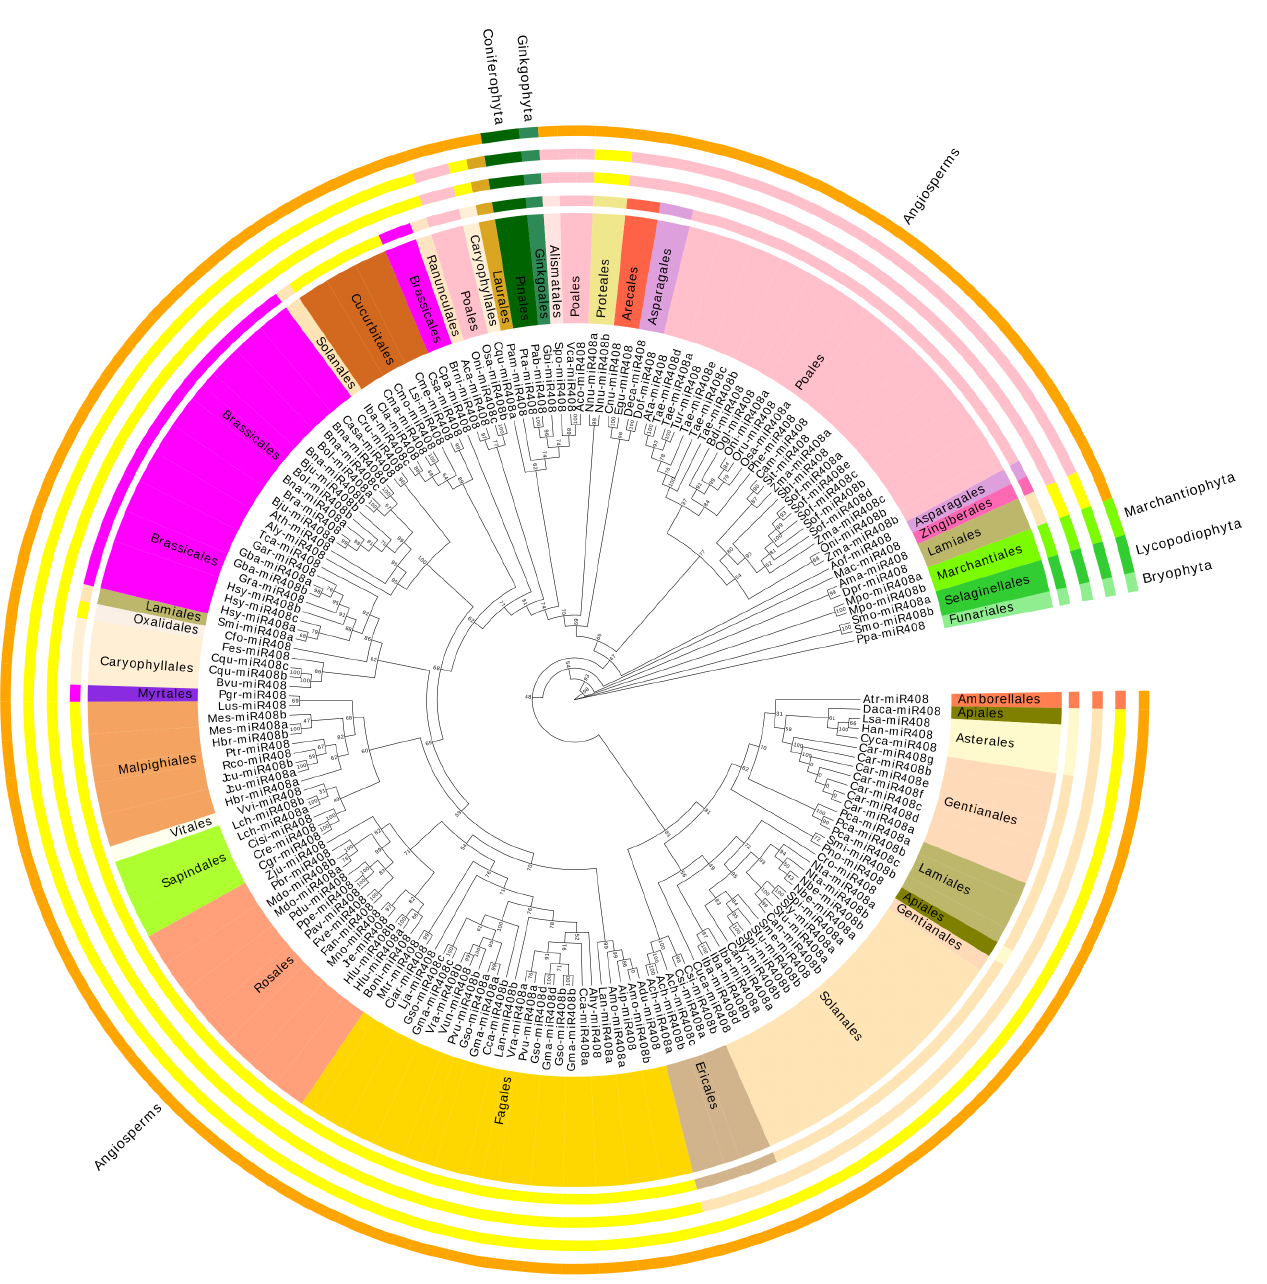
Figure 1. Phylogenetic analysis of miR408 precursor from 118 plant species. The miR408 precursor sequences were aligned with MAFFT. Maximum likelihood phylogenies were inferred using IQ-TREE under the TVMe+R5 model for 5000 ultrafast bootstraps. Evolview-v2 visualized the tree. Group labels from outside to inside were division, class, clade, order according to the 4th Angiosperm Phylogeny Group (APG) classification of